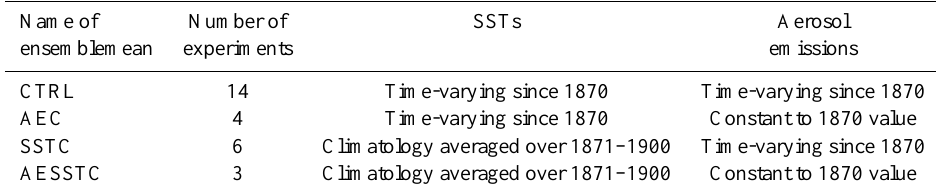
Table 1. Summary of the different simulations. All the simulations cover the period 1870 to 2005 and are forced with time-varying greenhouse gas concentrations since